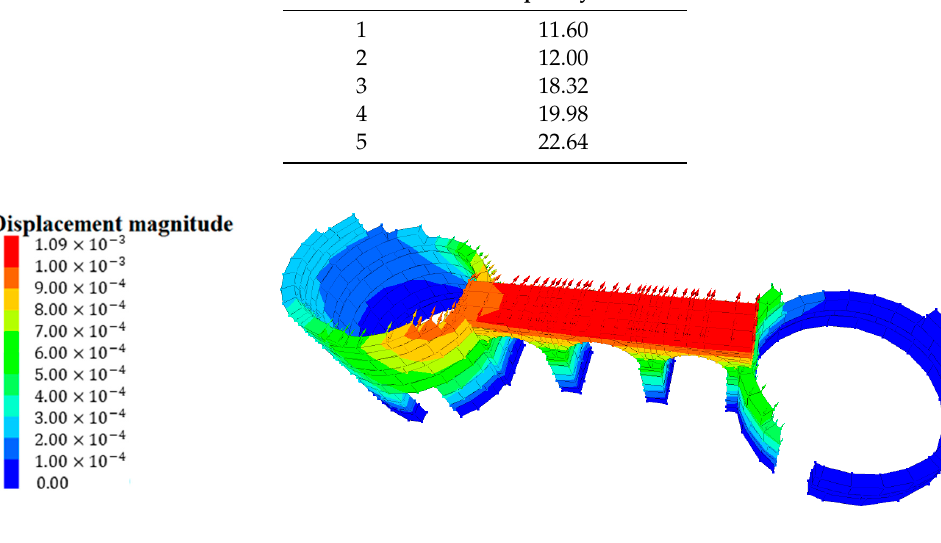
Figure 8. First Eigenmode .